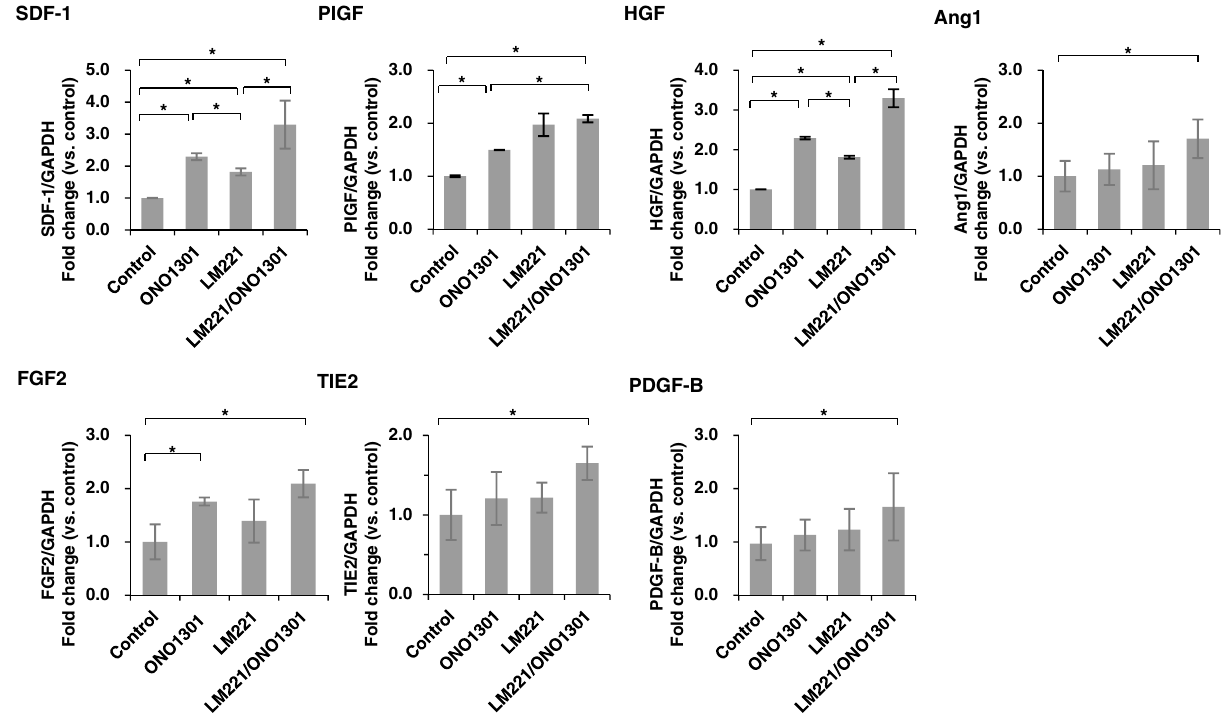
Figure 1. Combined administration of LM221 and ONO1301 induced chemotactic cytokine and angiogenic cytokine gene expression. The expression of SDF-1 , PlGF , HGF , Ang1 , FGF2 , TIE2 , and PDGF-B in the infarcted area was measured by quantitative reverse-transcription polymerase chain reaction. Data were normalised to GAPDH expression. * p <